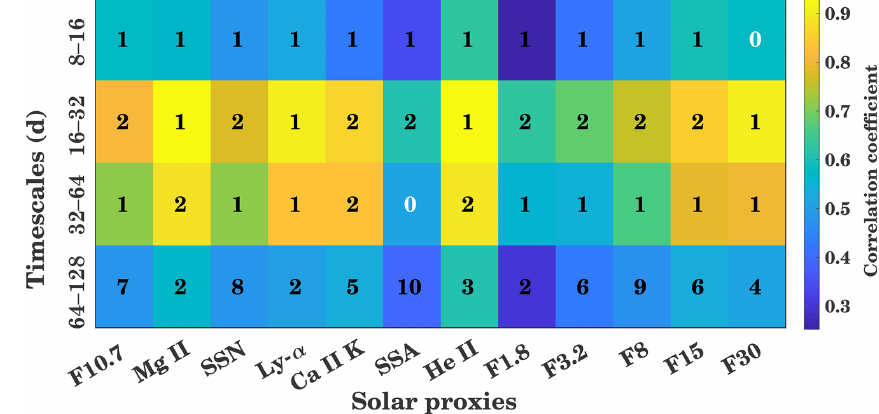
Figure 5. Wavelet cross-correlation sequence estimates for the maximal overlap discrete wavelet transform for GTEC and multiple solar proxies for different timescales (8 to 16, 16 to 32, 32 to 64, and 64 to 128d). The background color shows the correlation coefficient, and the inserted number shows the delay in days.